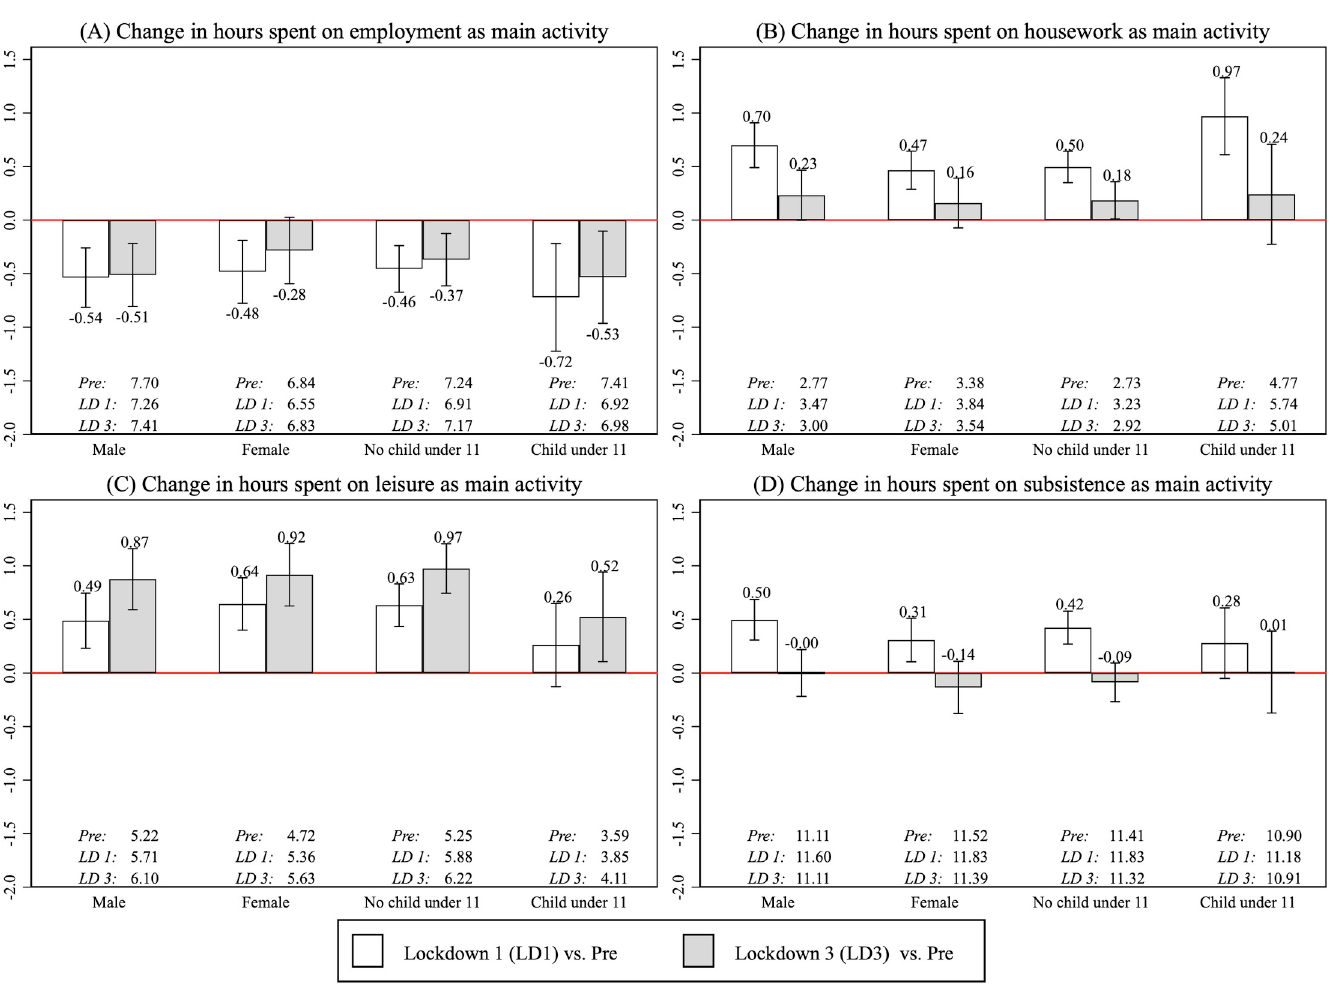
Fig 1. Within-person changes in time spent on 4 broad activity categories. Bars present average within-person changes in quantity of time use between the pre- pandemic timepoint (February 2020) and the first lockdown (May 2020) or the third lockdown (March 2021). Within-person changes for employment activities were calculated using the subset of individuals who remained employed in both periods of interest. Error bars represent 95% confidence intervals, and average levels for each subgroup are reported underneath the bars. Note that the conditional means were calculated separately (either by gender or household composition), so the four subgroups shown are not mutually